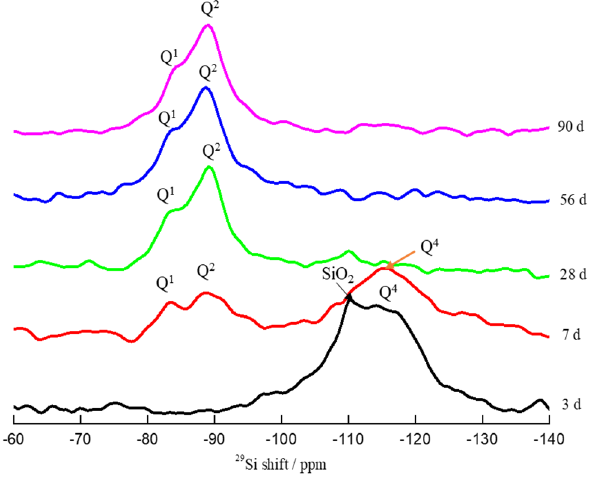
Figure 9. 29 Si MAS-NMR spectra of samples with initial C/S molar ratio of 1.0 after different curing Figure 9. 29 Si MAS‑NMR spectra of samples with initial C/S molar ratio of 1.0 after different times. curing